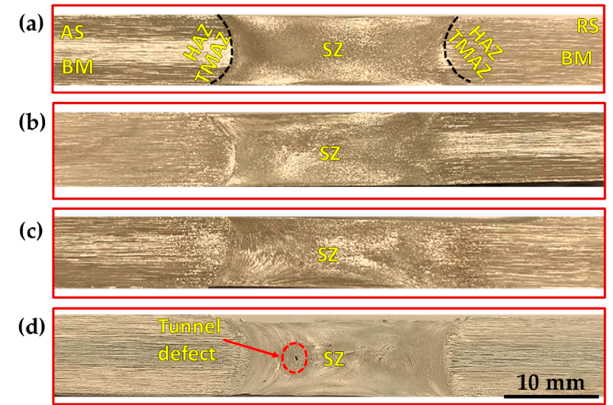
Figure 13. Macrostructure of the AA1050 BT-FSPed specimens at a constant rotation rate of 600 rpm using Tr pin (where BM: base material, SZ: stir zone, HAZ: heat-affected zone, and TMAZ: thermo- mechanically affected zone) and different travel speeds of ( a ) 50 mm/min; ( b ) 100 mm/min; ( c ) 200 mm/min, and ( d ) 300 mm/min.